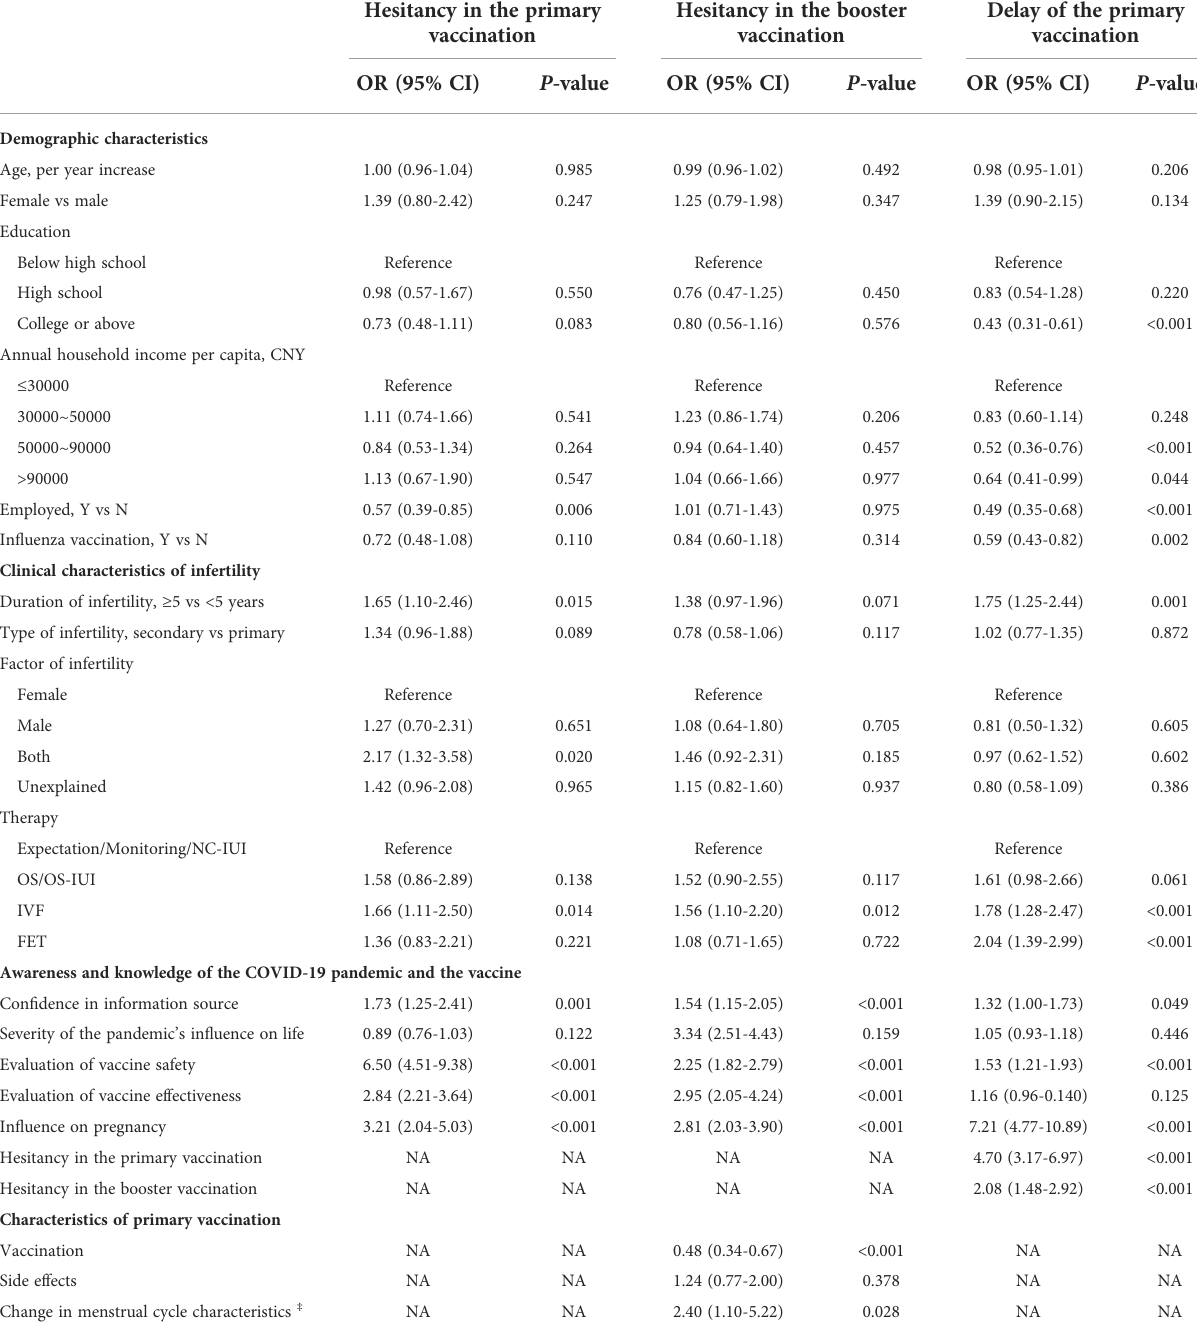
TABLE 2 Associated factors of COVID-19 vaccine hesitancy and coverage rate (univariate